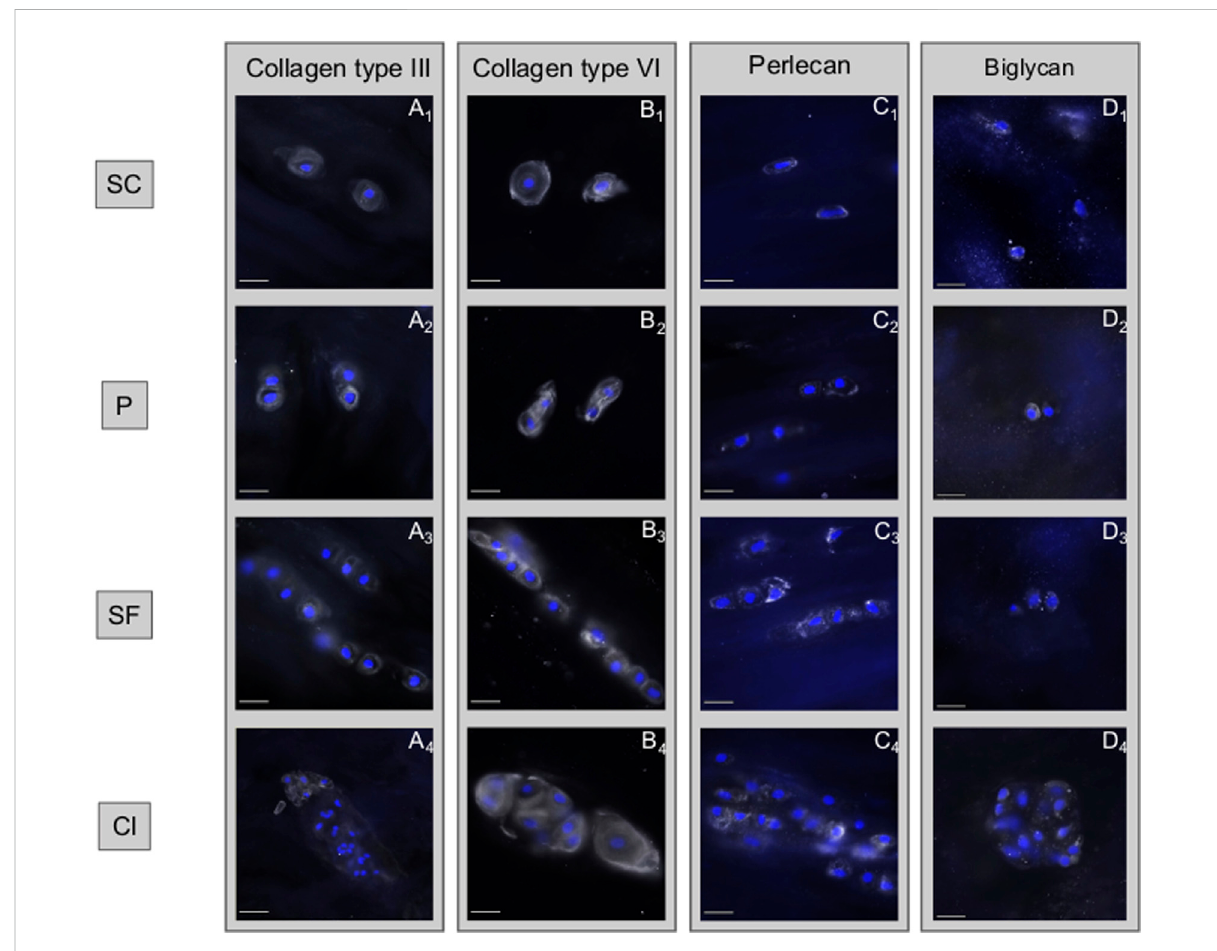
FIGURE 7 Disruption of collagen type III and softening of the pericellular matrix are observed in chondrocyte clusters. Immunohistochemical analyses of different matrix components of the intervertebral disc based on the different spatial cellular patterns. (A) Collagen type III is fi rmly present in the healthy pericellular microenvironment of single cells (SC), pairs (P) and string-formations (SF) while it is mostly absent in clusters (Cl). (B) While collagen type VI is constantly present in all spatial patterns, being a marker for the pericellular matrix, it highlights the loss of structural con fi nement of this structure. (C) This loss of spatial con fi nement appears also for perlecan. (D) The ubiquituously present matrix proteoglycan biglycan remains largely unaffected by the changes taking place. (A – D) describes different subtypes of matrix components that are present in the matrix, the numbers 1 – 4 describe how each of these matrix components changes with time. Abbreviations: SC, single cells; P, pairs; SF, string- formations; C,